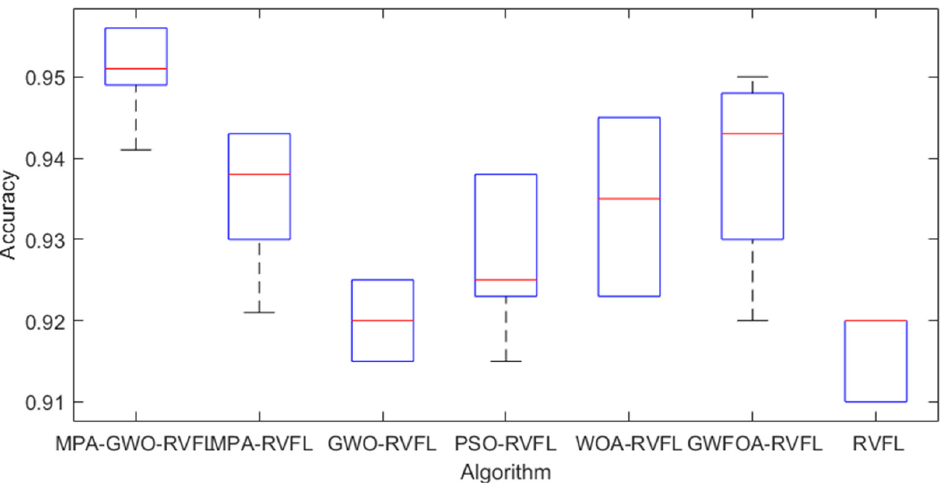
Figure 6. Stability analysis box diagram.